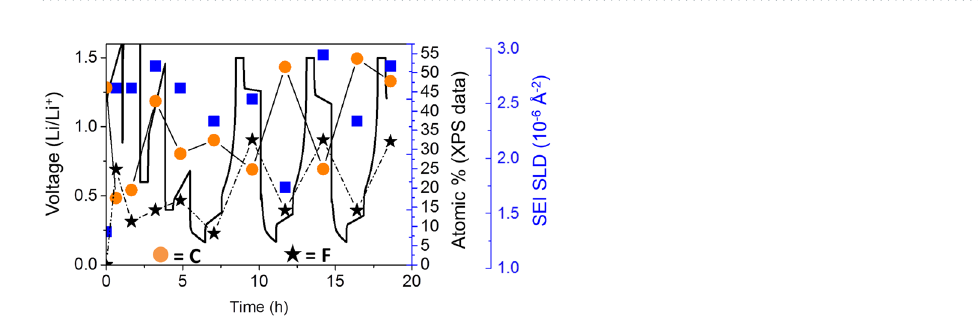
Figure 9. Plot of C and F atomic concentrations as a function of state of charge and SEI